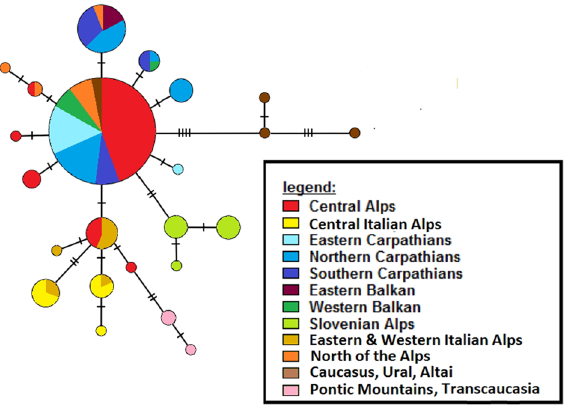
Figure 2. Minimum spanning Haplotype network of E. aethiops based on a COI fragment (429 bp). Mutational steps are indicated by the number of hatch